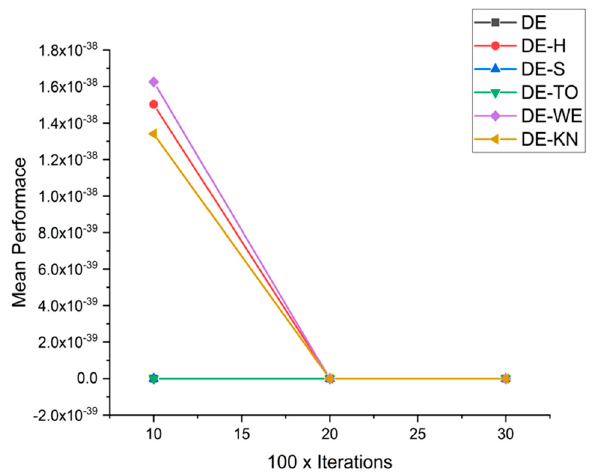
Figure 25. Convergence curve on fn3.